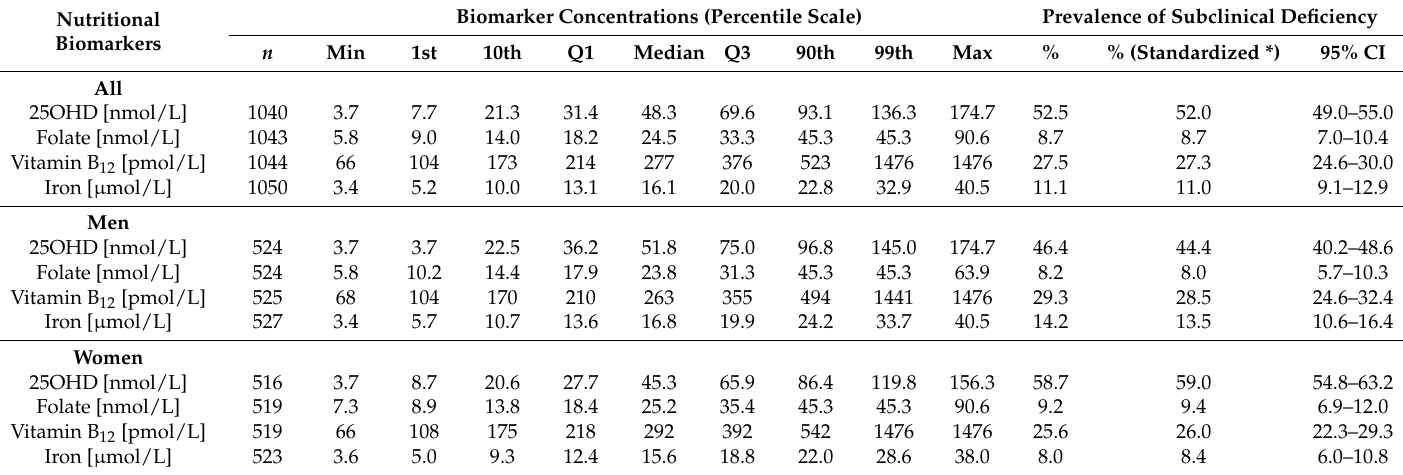
Table 2. Biomarker concentrations and prevalence of subclinical micronutrient deficiencies by sex in KORA-Age 2008/2009. Nutritional